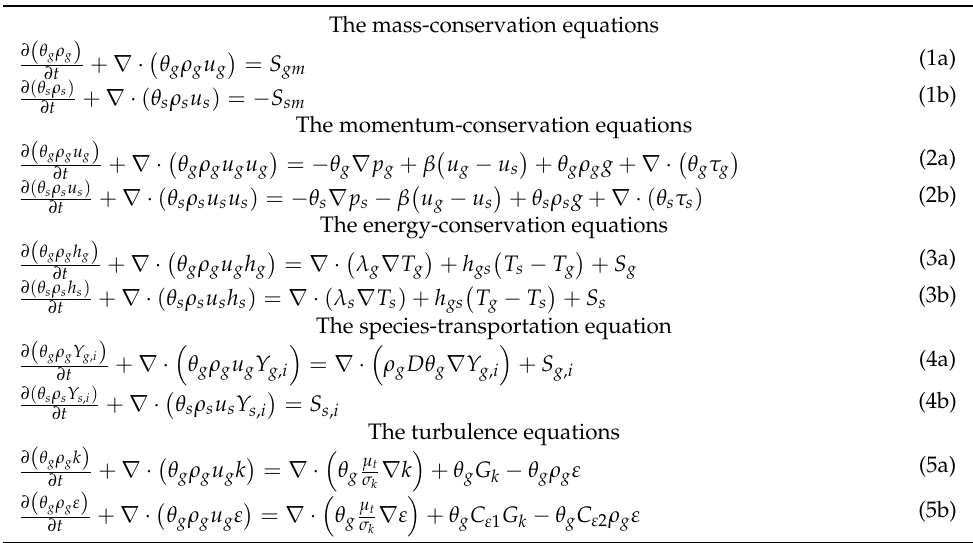
Table 1. Governing equations of the Eulerian–Eulerian